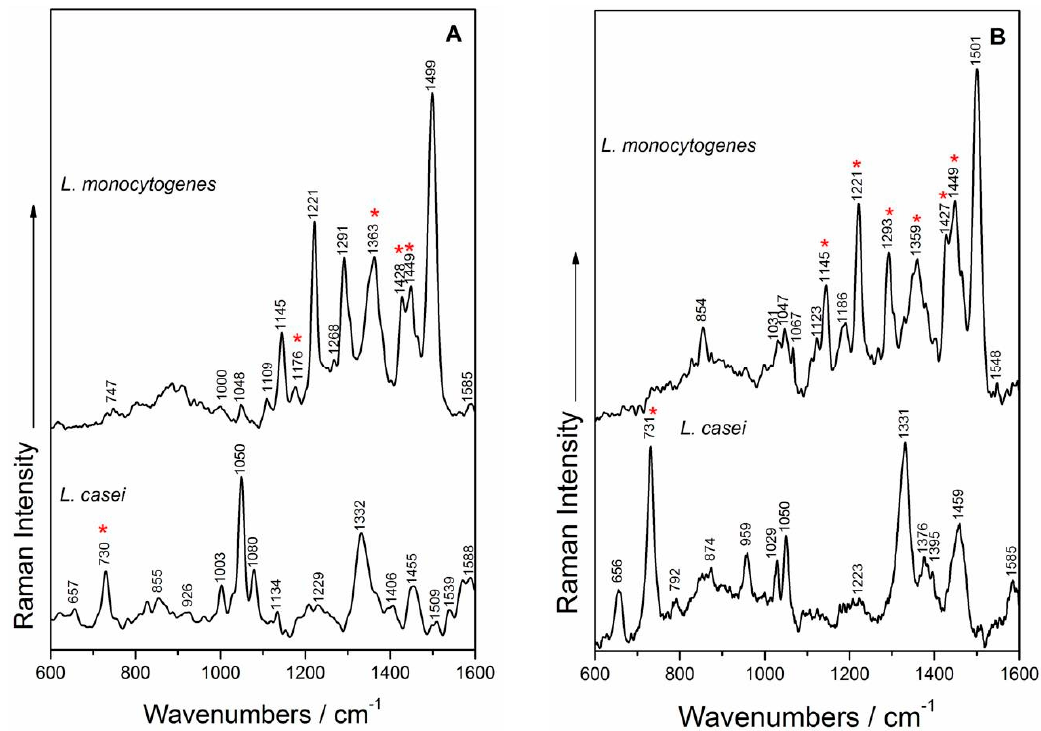
Figure 5. SERS spectra using a priori prepared Ag colloid ( A ) of L. monocytogenes (top) and L. casei (bottom) and in situ synthesized Ag nanoparticles ( B ) of L. monocytogenes (top) and L. casei (bottom). The “*” symbol indicates the SERS bands contributing to the PCA discrimination.